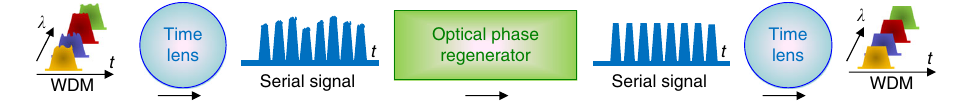
Fig. 1 Basic concept of the proposed WDM regeneration. A time-lens-based OFT unit converts the WDM input signal to a high-speed serial optical single, which is then straightforward regenerated in a single PSA-based regeneration without inter-channel cross-talk. After regeneration, the serial signal is transformed back to a WDM signal using a second reciprocal time-lens unit